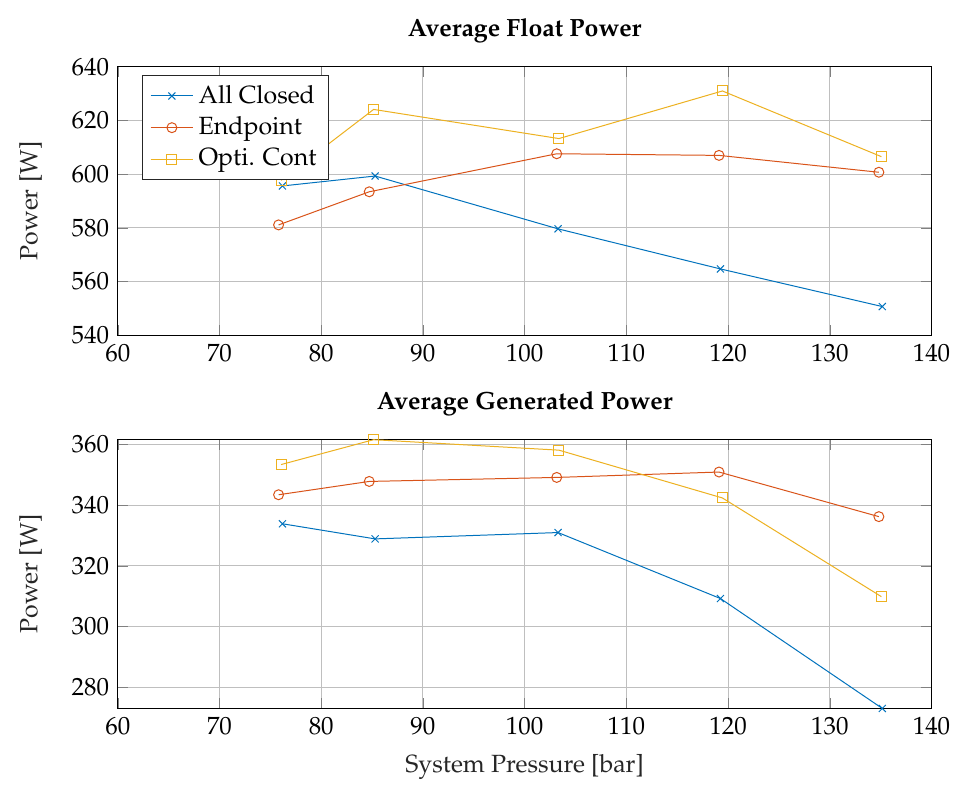
Figure 14. Measurements of absorbed and Generator power as a function of systems pressure using different WPEAs. Wave input: Irregular